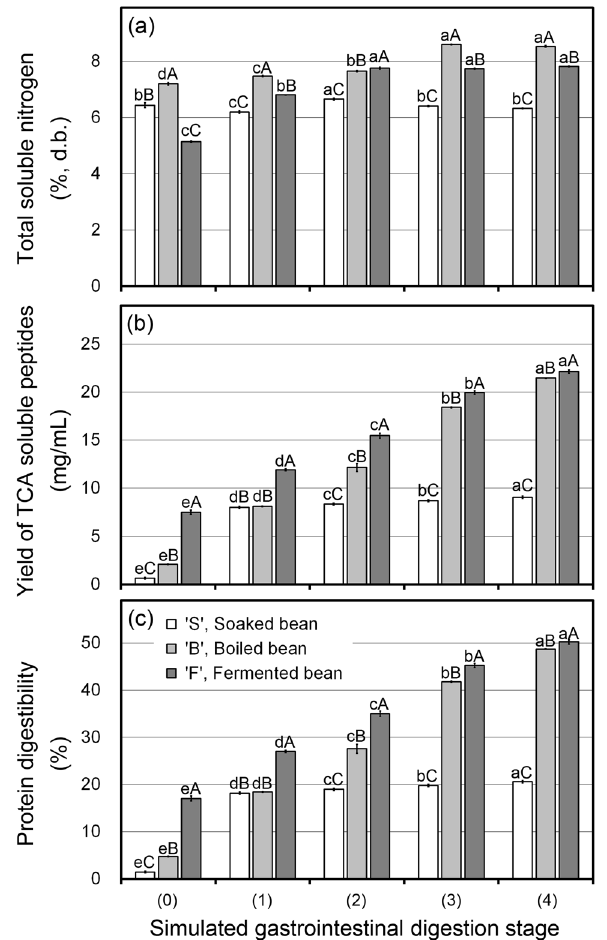
Figure 1. Change in total soluble nitrogen content (TSN) ( a ), yield of TCA-soluble peptides ( b ), and protein digestibility ( c ) of soaked (S), boiled (B), and fermented (F) soybeans at each digestion stage (0–4). Bars represent the standard deviation. Different lowercase and uppercase letters indicate significant differences ( P < 0.05) among digestion stages and among manufacturing steps,